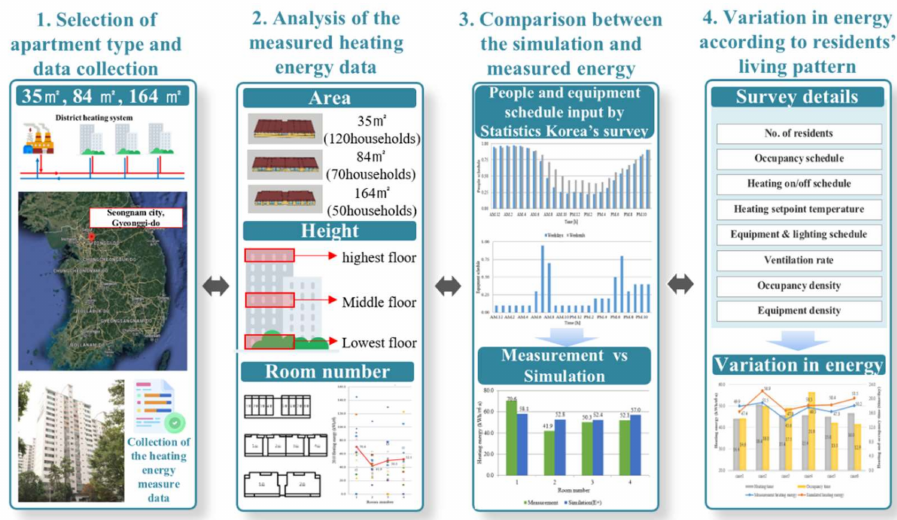
Figure 1. Study flow